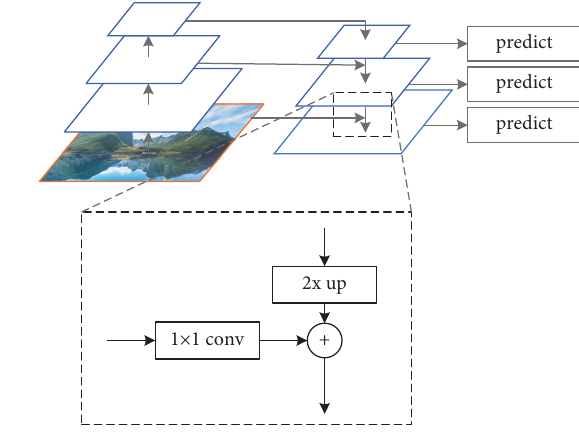
Figure 3: FPN structure.